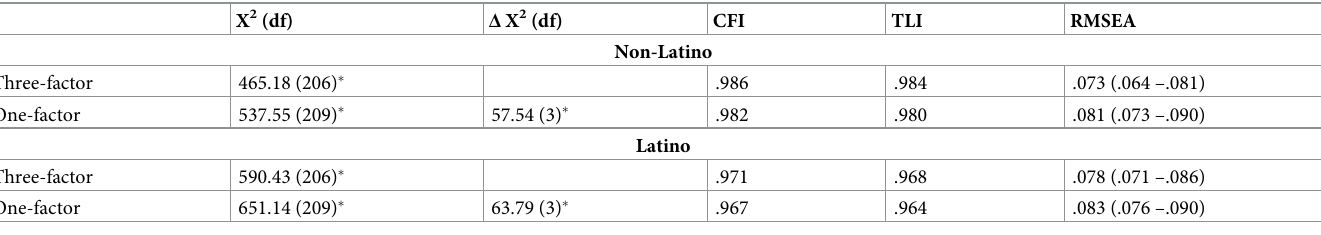
correlations. High correlations such as these have been found in previous research on the IES-R [21, 31]. The one-factor solution produced standardized item factor loadings ranging from 0.51 to 0.92 ( R 2 values ranged from 0.26 to 0.85), indicating items loaded strongly on the single factor. In order to further assess whether the unidimensional structure is appropriate, we estimated a bifactor model as a follow-up analysis. The bifactor model, applied to the entire sample of Latino and non-Latino participants, fit the data well ( χ 2 = 684.53, RMSEA = .070, 90% CI = .064-.075, CFI = .982). The explained common variance (ECV) for the general factor was .92, which indicates that the IES-R is sufficiently unidimensional to warrant a one-factor model [76, 77]. Thus, the invariance testing process was conducted on the single factor (i.e., total score) solution.